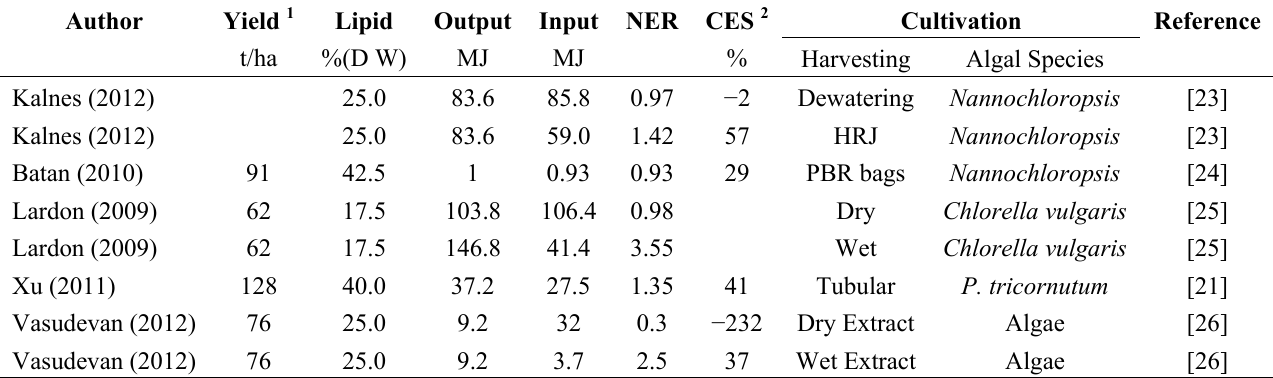
Table 2. Energy input (expense) and greenhouse gas (GHG) emission for producing 1 kg algal oil and energy yield